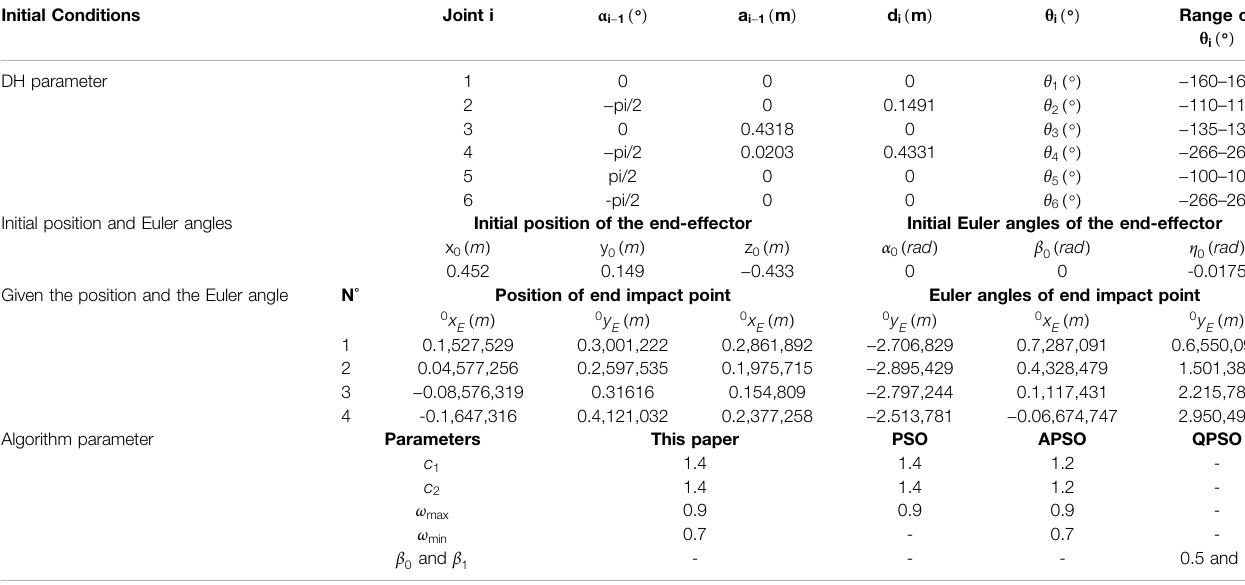
TABLE 6 | Initial condition setting of PUMA560 robot arm.